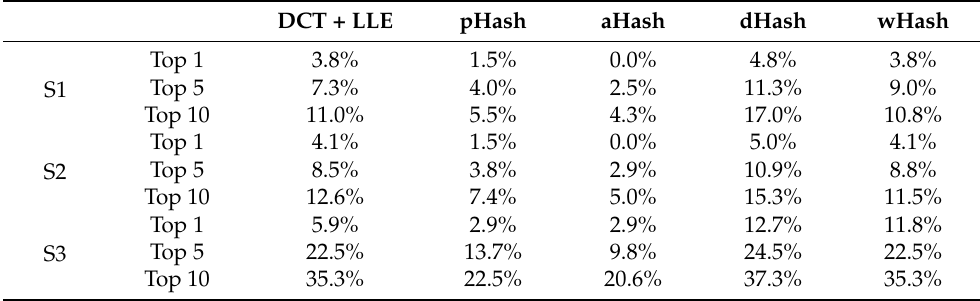
Table A2. Correct matches results for database vs. TS2 comparison—without Radon transform or contrast stretching application